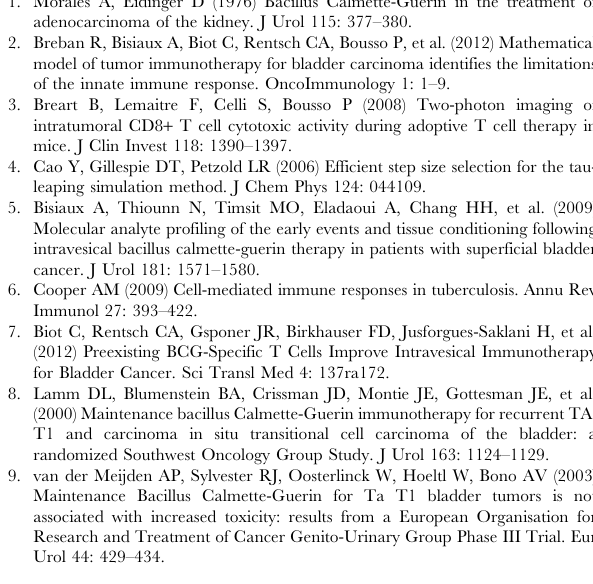
Figure S1 Flow diagram of the model of interactions between the innate immune system and bladder tumor during BCG instillation. Figure S2 Simulation of logistic tumor growth, resec- tion and tumor re-growth. The horizontal dashed line represents the approximate size of the tumor when the tumor is visible on the bladder wall. Figure S3 Simulation of population dynamics of cells during and after a six-week course of intravesical BCG therapy. BCG (panel A ), tumor cells (panel B ), BCG-associated tumor cells (panel C ), BCG-associated tissue cells (panel D ), innate effector cells (panel E ), adaptive effector cells (panel F ). Note the modeling of the prime/boost response of the innate and adapted immune system occurring after the third instillation (in particular, note panels E and F ). Figure S4 Sensitivity analyses for Figs. 2A and 3 of the main text. A . Sensitivity analysis of Fig. 3 with changing the rate